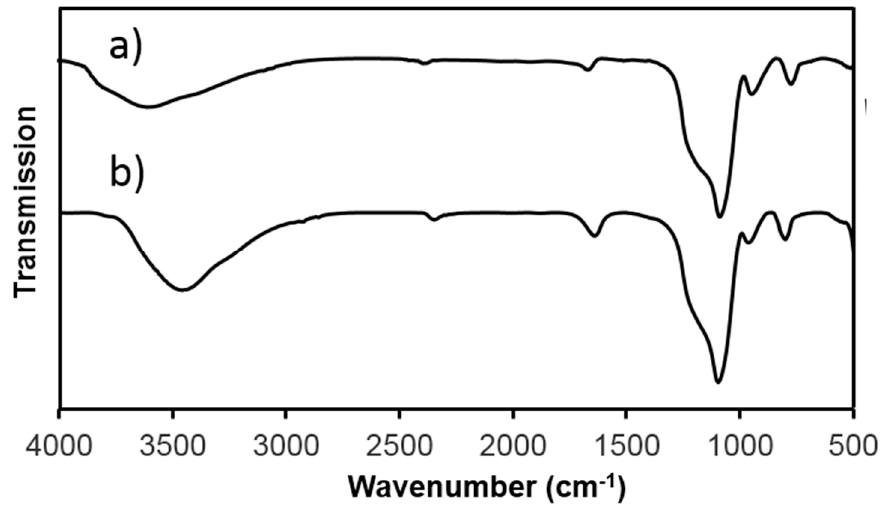
Figure 2. The FTIR spectra of PNS ( a ) and HMSN ( b ).